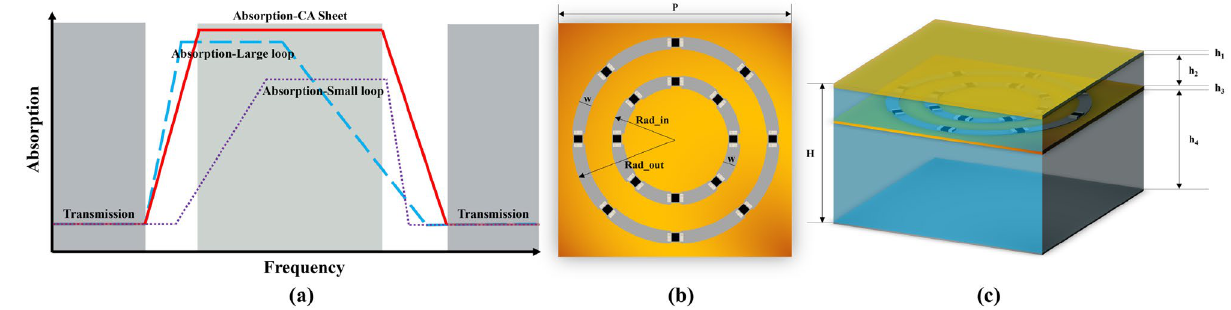
Figure 3. Geometrical configuration of the proposed CA absorber. ( a ) Design goal of unit cell; ( b ) Unit cell of the CA sheet; ( c ) Perspective view of proposed absorber.